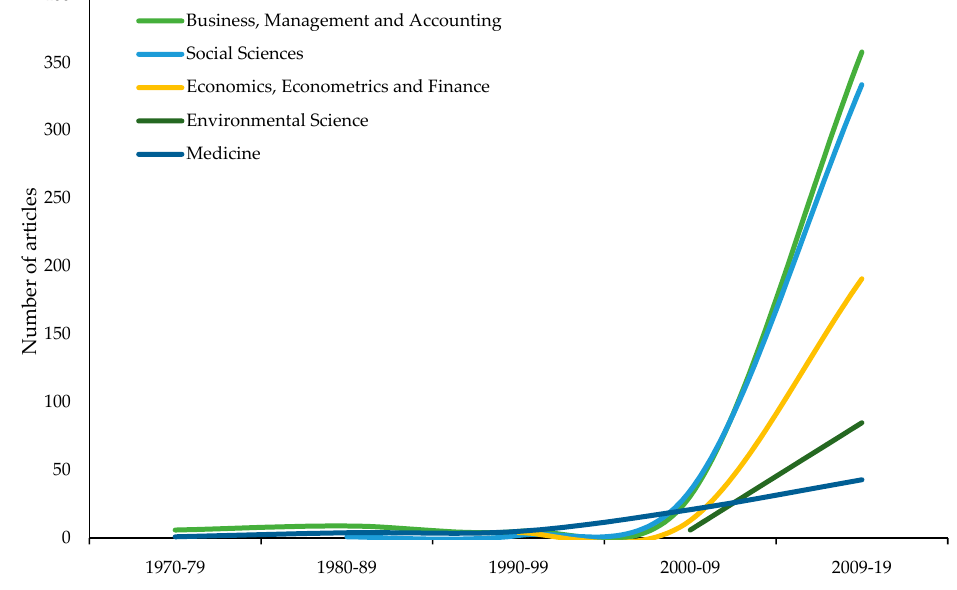
Figure 4. Comparisons of the growth trends of subject areas (1970–2019).